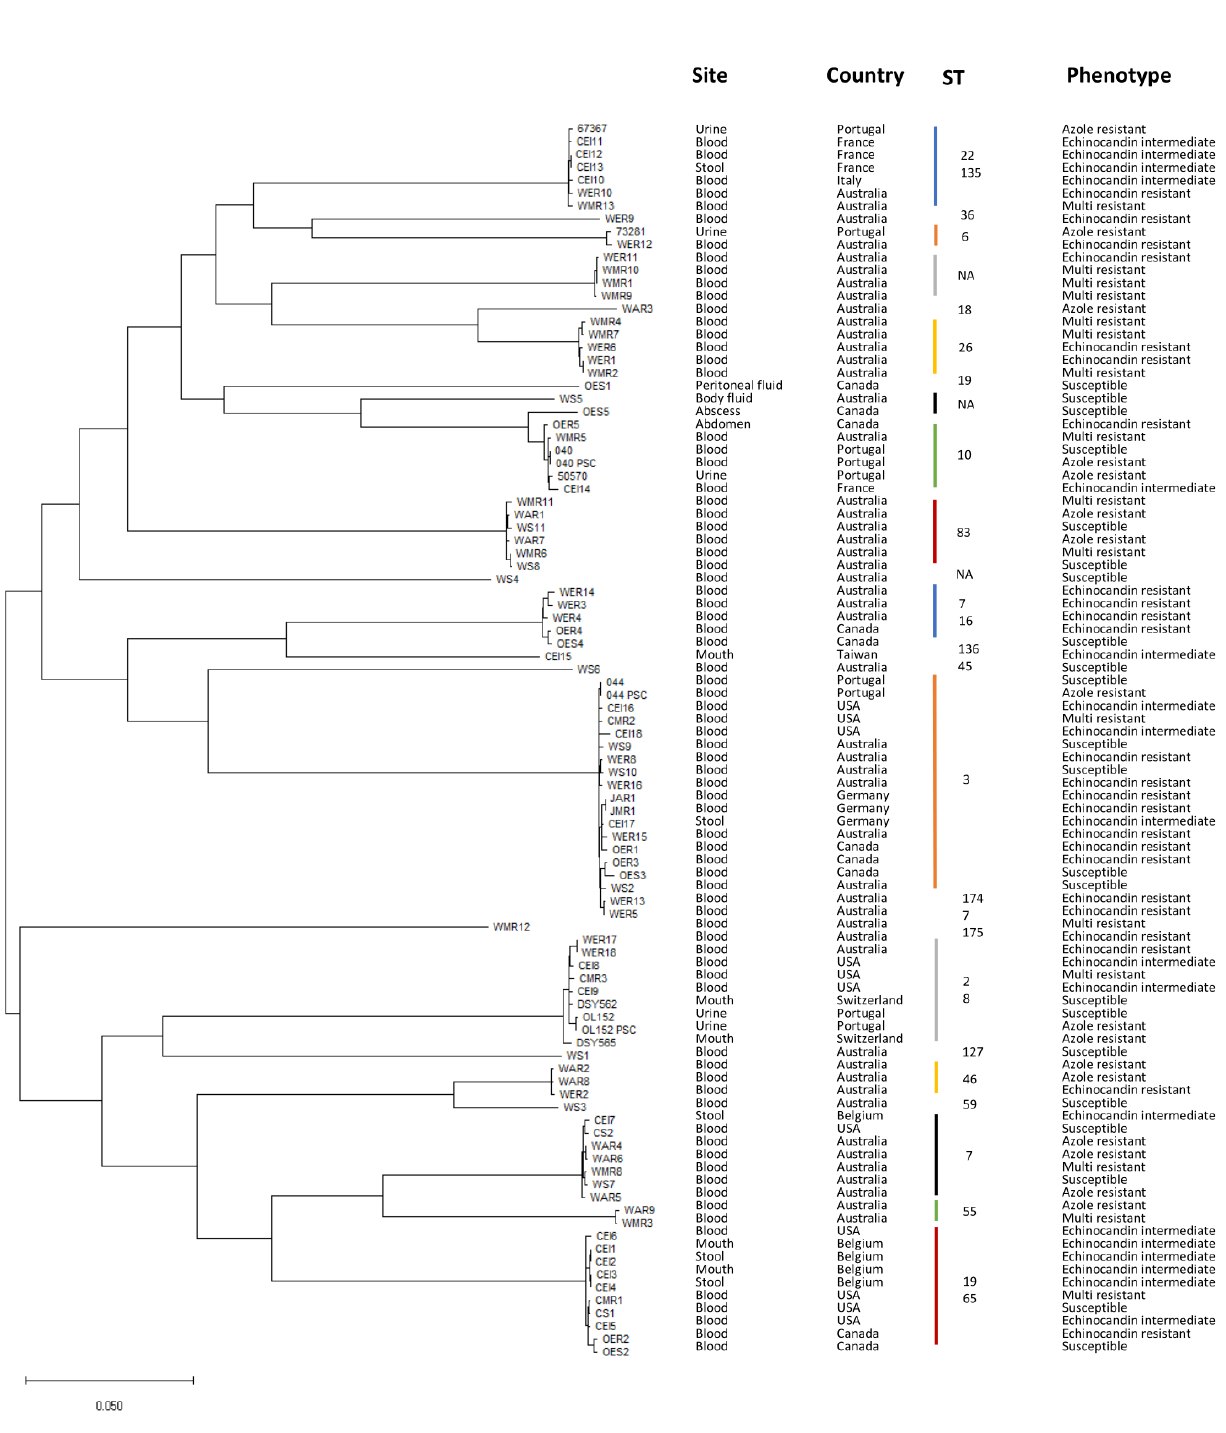
FIGURE 1: Isolates phylogeny. Phylogenetic tree representing evolutionary distances among the 97 C. glabrata isolates analyzed in this study. Phylogeny was inferred using CSI Phylogeny 1.4 [51] and tree representation was generated with MEGA [52]. ST – Sequence